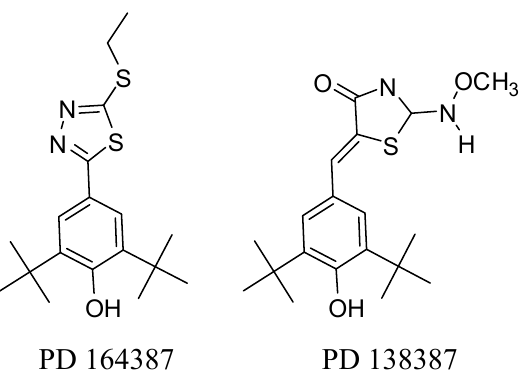
Figure 2. Parke-Davis COX-2